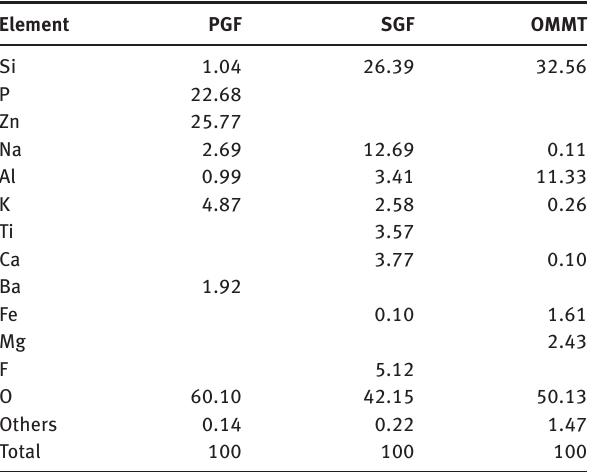
Table 1: Major components of PGF, SGF and OMMT in terms of ele- ments in